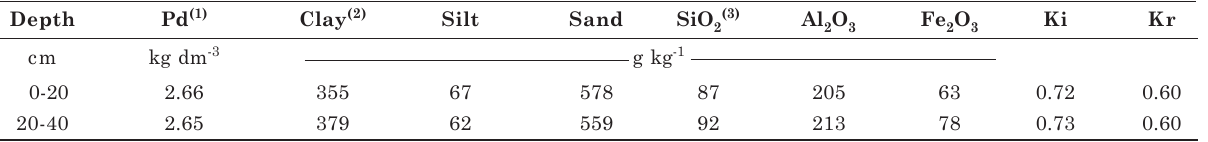
(1) Pd: Particle density, determined by the volumetric flask method (Embrapa, 2011); mean of 16 repetitions. (2) Determined by the pipette method (Embrapa, 2011); mean of 16 repetitions. (3) Oxide content; mean of three repetitions. Ki: molecular relationship (SiO /Al O ); Kr: molecular relationship SiO 2 2 3